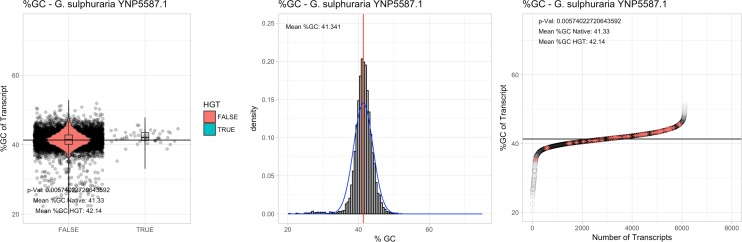
%GC – Galdieria sulphuraria Mount Shasta YNP5578.1: (Left) Violin plot showing the %GC distribution across native transcripts and HGT candidates.(Mid) Cumulative %GC distribution of transcripts. Red line shows the average, blue line a normal distribution based on the average value. (Right) Ranking all transcripts based upon their %GC content. Red ‘*' demarks HGT candidates. As the %GC content was normally distributed, students test was applied for the determination of significant differences between the native gene and the HGT candidate subset.